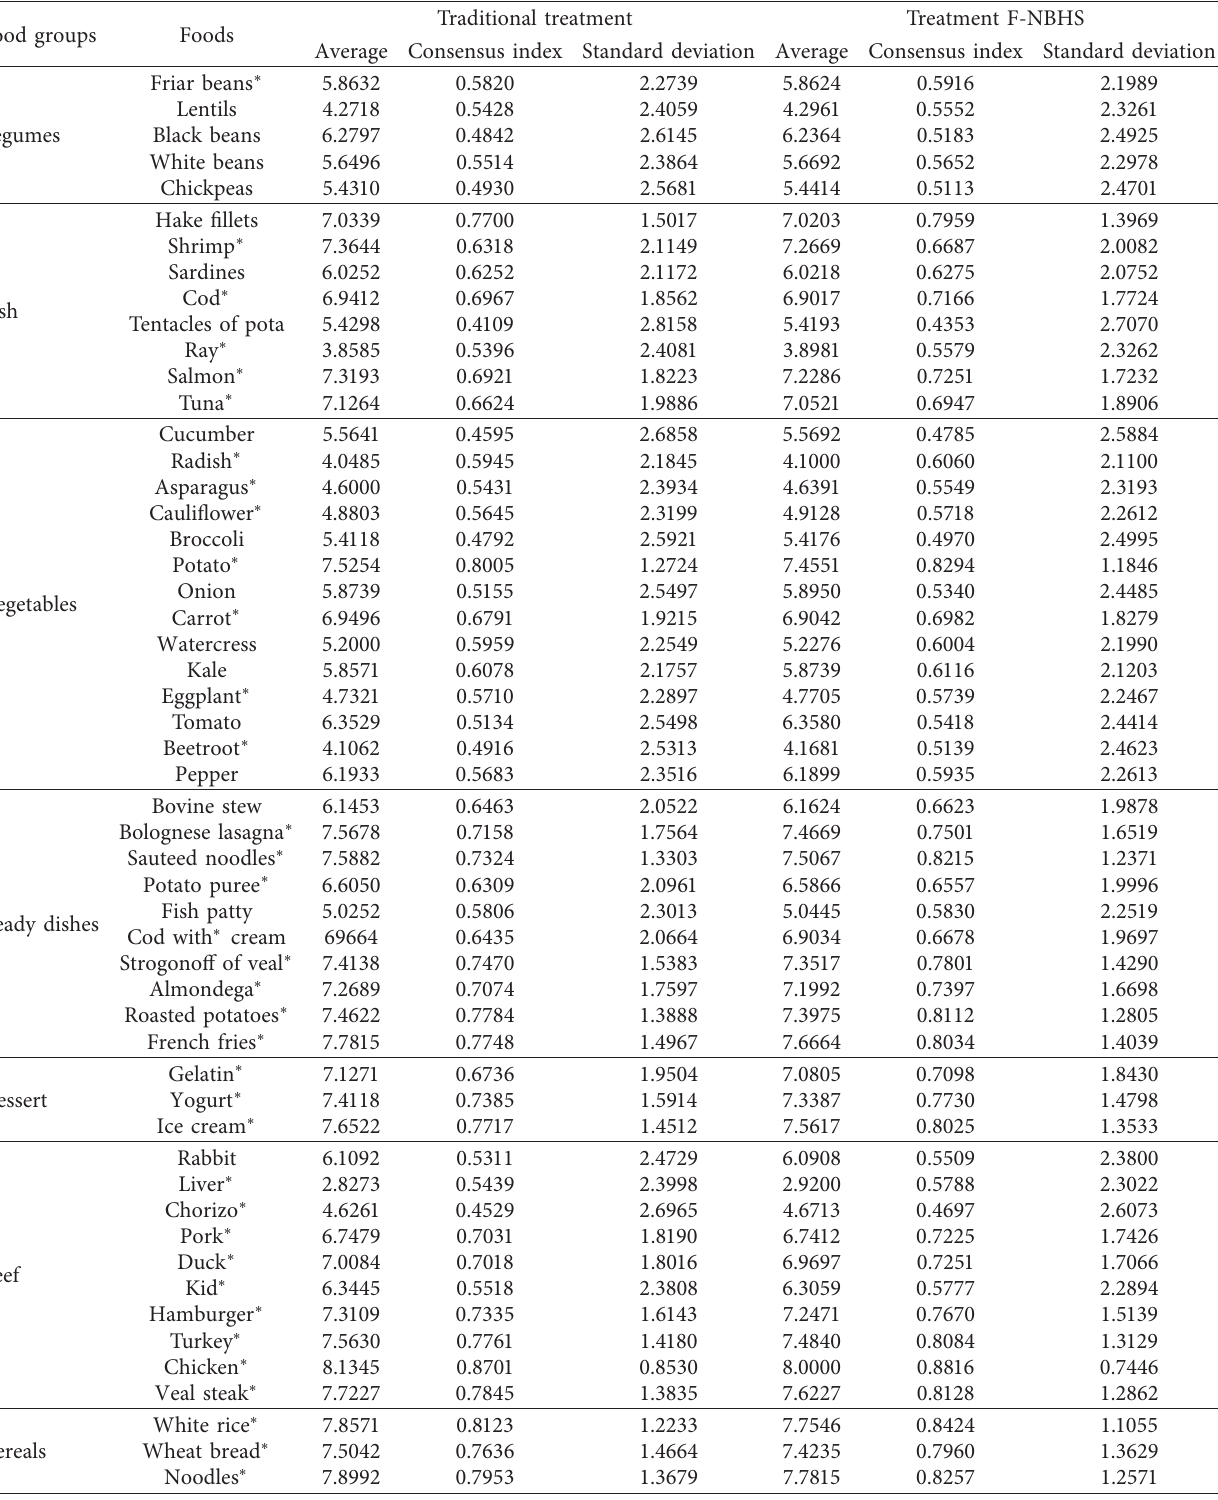
Table 8: Food preference results for food from the leguminous food group. Food